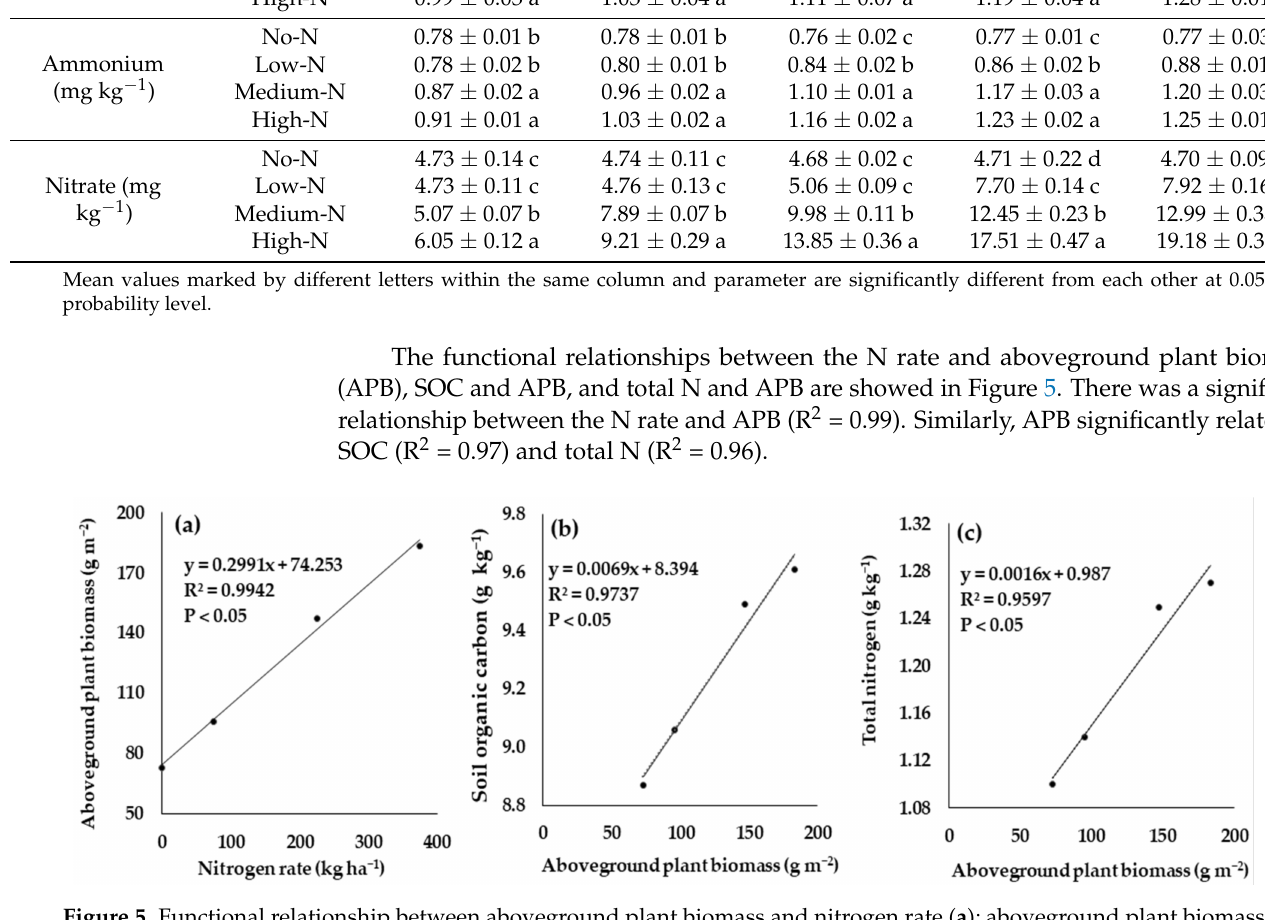
Figure 5. Functional relationship between aboveground plant biomass and nitrogen rate ( a ); aboveground plant biomass and soil organic carbon ( b ); aboveground plant biomass and total nitrogen ( c